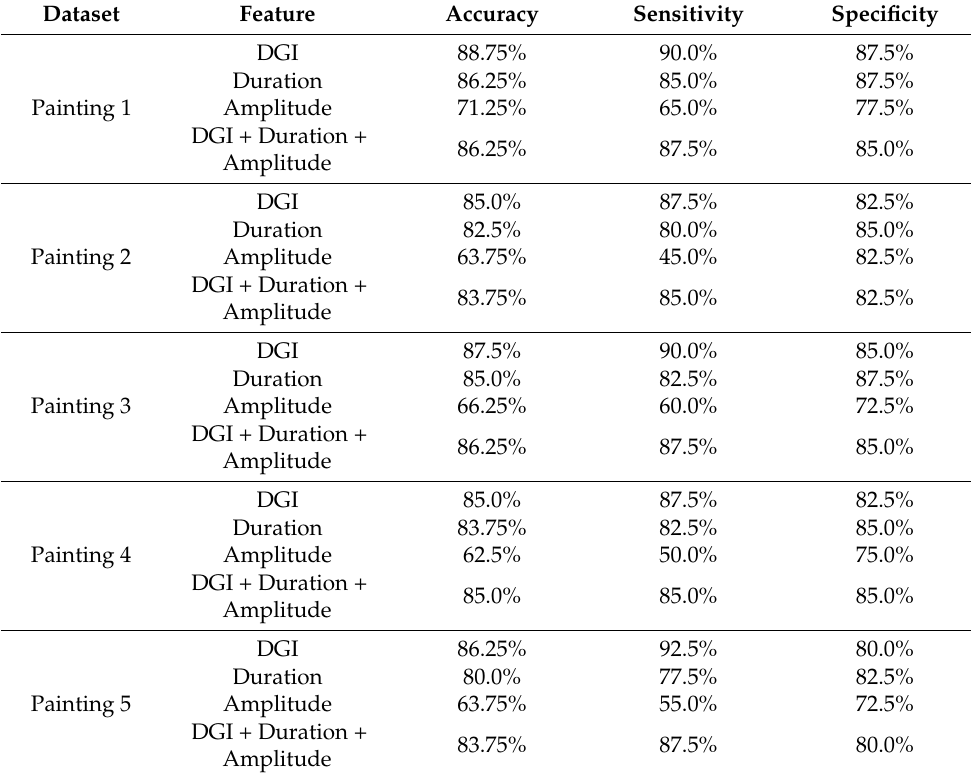
Table A7. Logistic regression scores for the seven DGI based